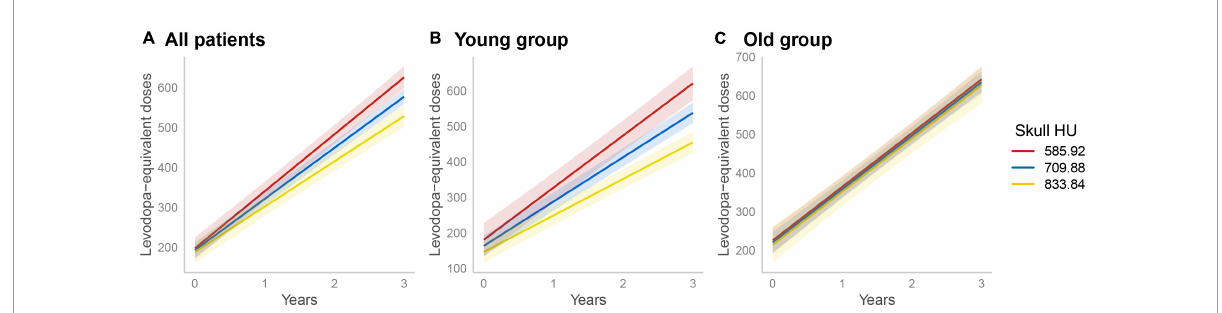
FIGURE2 Longitudinal increases in levodopa-equivalent doses. A linear mixed model analysis showed significant difference in longitudinal LED increase according to skull HU values (skull HU per 1 SD decrease × Time, p < 0.001) (A) . In the subgroup analysis, longitudinal LED increase significantly differed according to skull HU in the young age group (B) , but not in the old age group (C) . The light red, blue, or yellow band represents the 95% confidence interval in each point of skull HU. LED, levodopa-equivalent doses; HU, Hounsfield unit; SD, standard deviation.